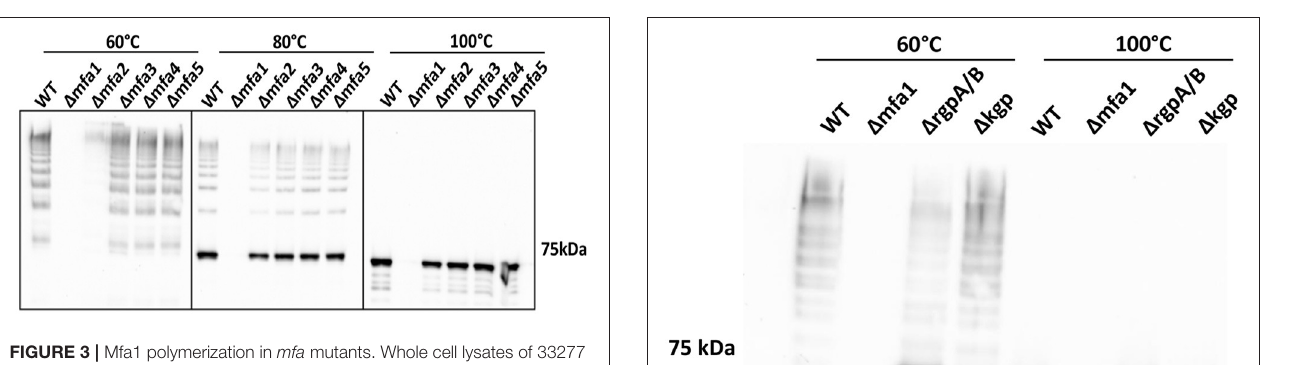
FIGURE 3 | Mfa1 polymerization in mfa mutants. Whole cell lysates of 33277 WT and mfa mutants were treated at 60 ◦ , 80 ◦ , and 100 ◦ C prior to SDS-PAGE and immunoblotting with antibodies to Mfa1. Results are representative of 4 biological replicates.